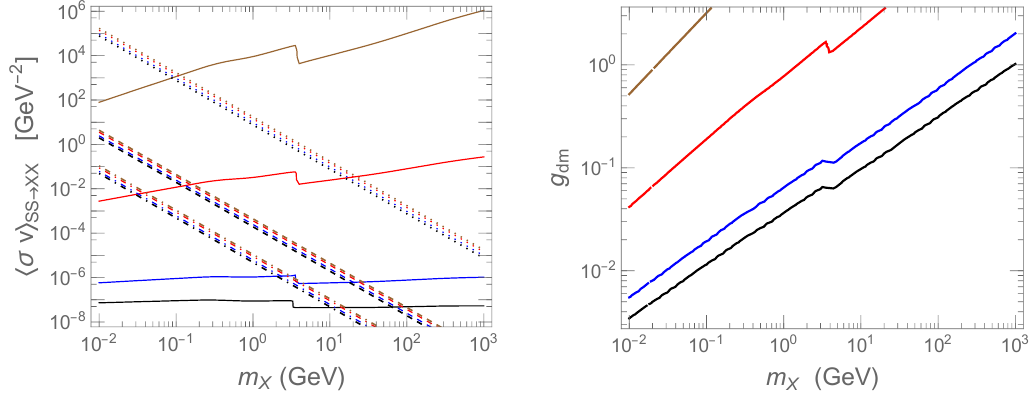
Figure 2 . Left panel: thermal cross section h σv i SS → XX at T = T f as a function of m X . Dotted, dashed, and dotdashed lines are thermal cross sections in the vector dark matter model using the √ inputs g dm = 4 π, 0 . 252 and 0 . 1 , respectively, in comparison with the results that can produce correct relic density (solid lines in the horizontal direction) as shown in the right panel of figure 1. Right panel: coupling constant g dm as a function of m X , that can produce the correct relic density as discussed in section 2. Again, from bottom to up, the lines (with black, blue, red, and brown) correspond to r (= m S /m X ) = 1 . 01 , 1 . 05 , 1 . 25 , 1 . 5 ,